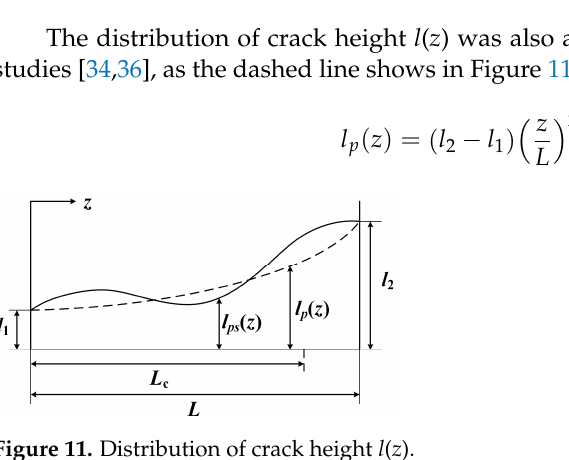
Figure 11. Distribution of crack height l ( z ).